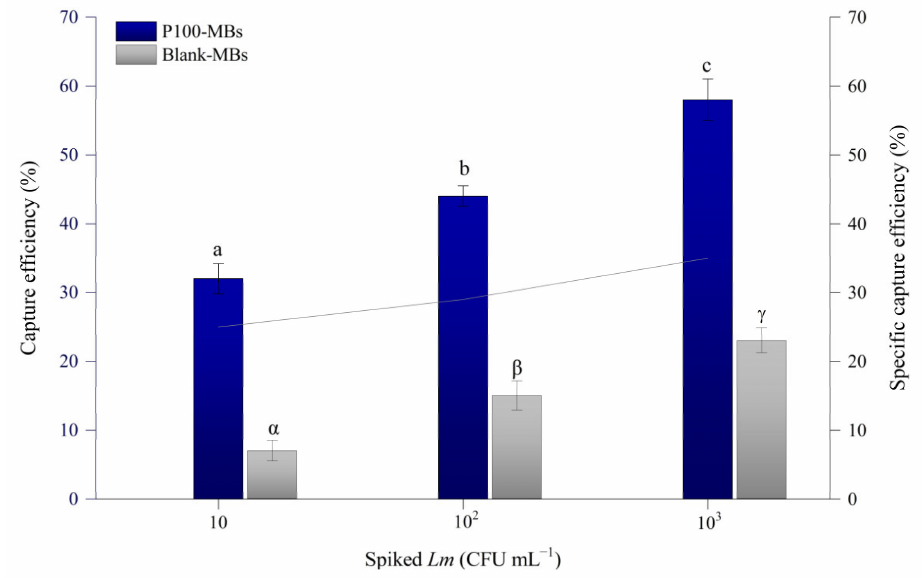
Figure 7. Phagomagnetic separation of L. monocytogenes from spiked (10–10 3 CFU mL − 1 ) pasteurized milk utilizing P100–MBs (32 µ g, 25 ◦ C), following 30 min of incubation. Capture efficiency (%) (columns) and specific capture efficiency (%) (solid line) were determined. Each error bar was estimated as the standard deviation of three independent experiments. Different lowercase letters indicate statistical significance ( p <